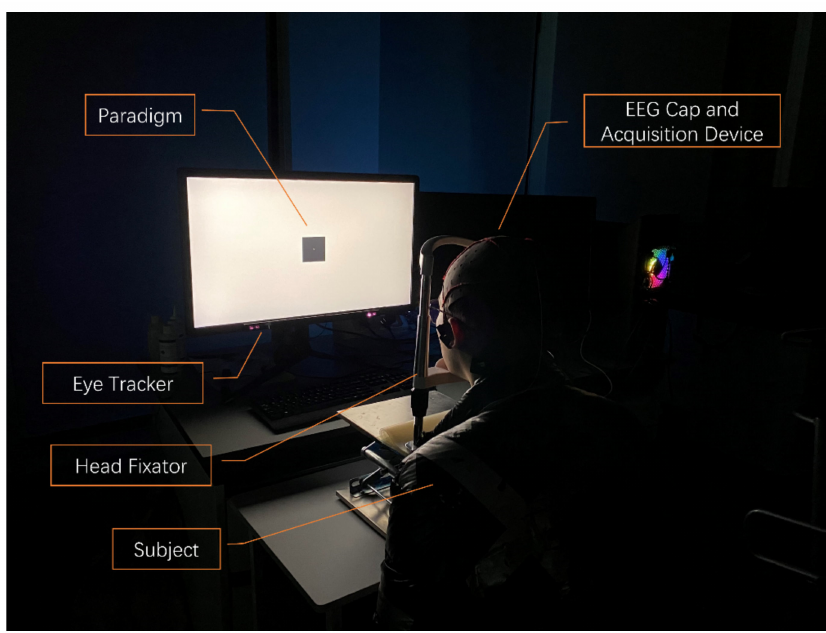
Figure 2. Experimental